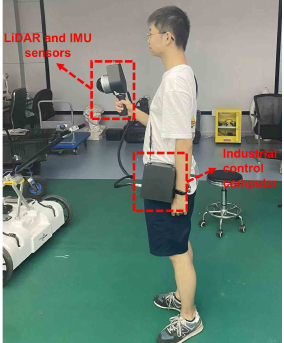
Figure 3. Handheld hemispherical view laser scanning system prototype.